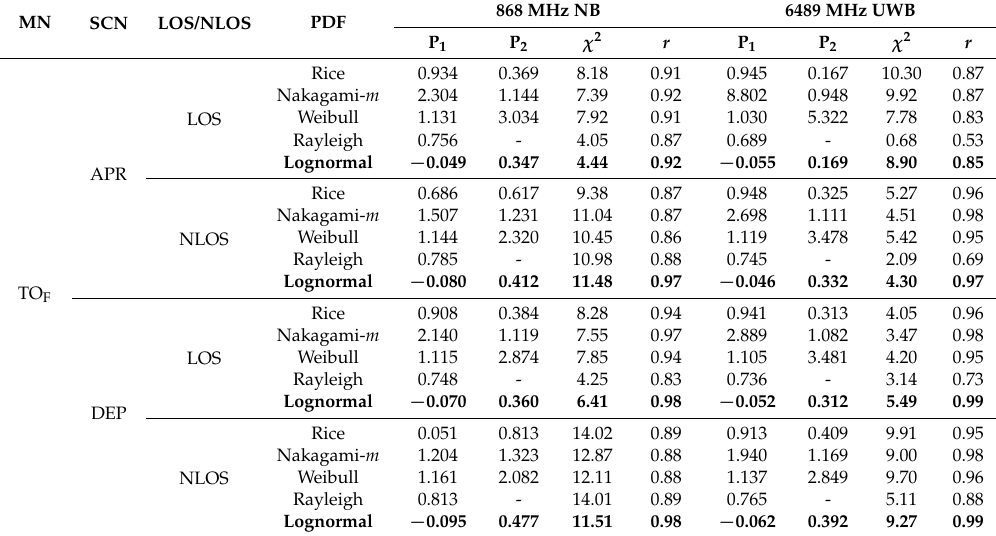
Table 4. The parameters of PDFs fitted to empirical distributions of small-scale fading amplitudes for TO F